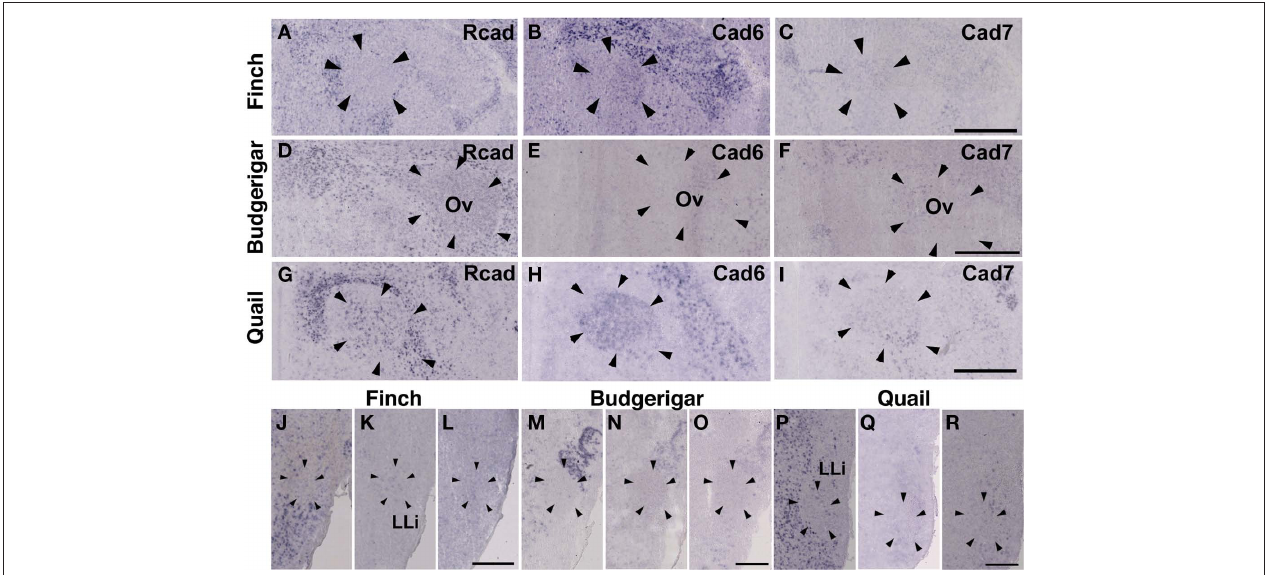
Figure 8 | Cadherin expression in the nucleus ovoidalis and intermediate nucleus of the lateral lemniscus in the auditory system. (A–i) In situ hybridization for Rcad (A,D,g) , cad6B (B,e,H) , and cad7 (C,F,i) in the Bengalese finch (A–C) , budgerigar (D–F) , and quail (g–i) in the nucleus